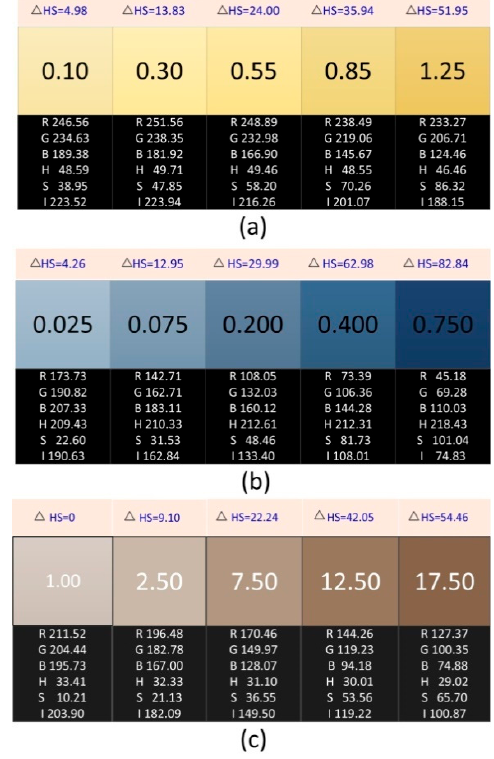
Figure 14. Image information of standard organic compound solution. ( a ) is the image information of different concentrations of ammonia nitrogen solution. ( b ) is the image information of different concentrations of phosphate solution. ( c ) is the image information of different concentrations of chloride solution.